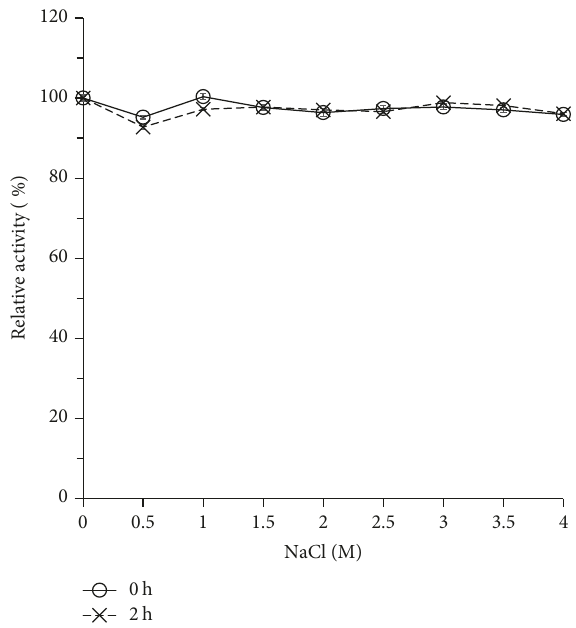
Figure 8: Effects of water-miscible organic solvent on XynA MG 1 xylanase activity and stability. The xylanase activity at the starting time and without organic solvent added was taken as 100%. The data were presented as mean ± SD ( 𝑛 = 3 ) (for experimental details, please see the main